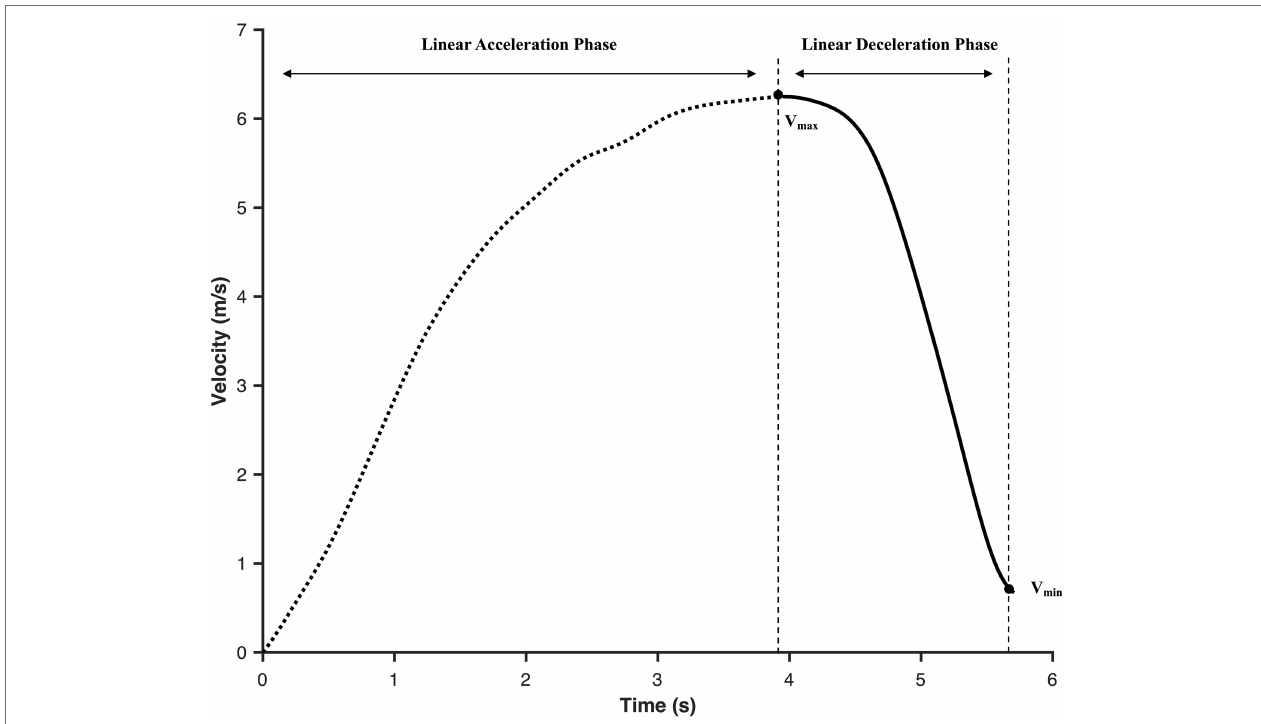
FIGURE 2 | Example of velocity-time profile showing the acceleration and the deceleration phase. V max , maximum velocity defining start of deceleration phase; V min , lowest velocity defining end of deceleration phase.